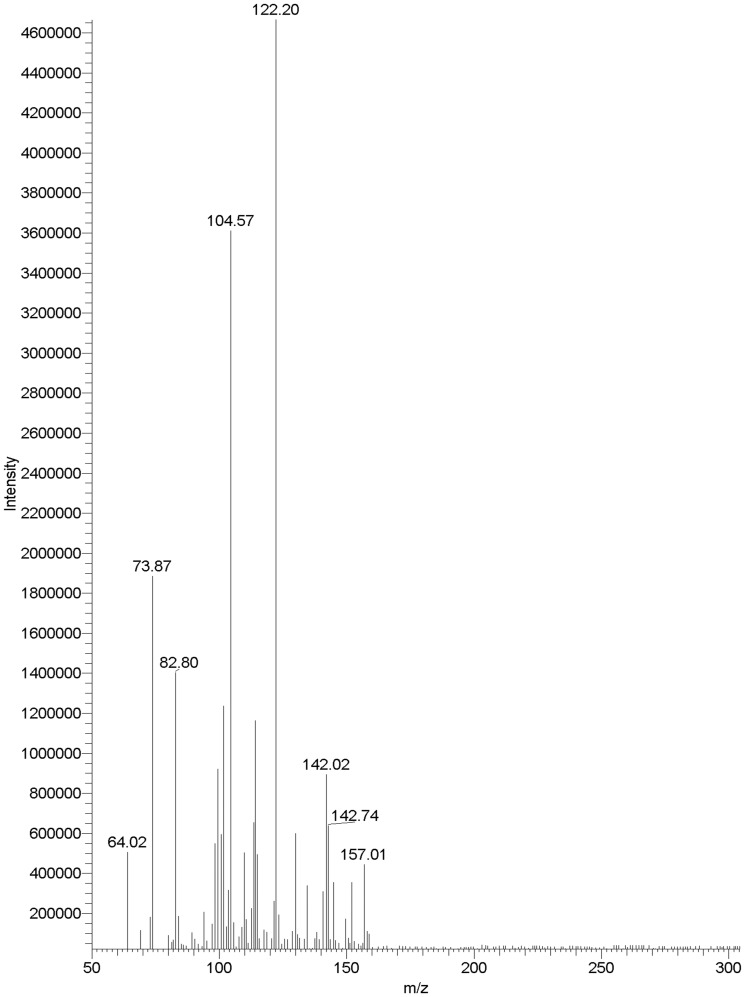
Mass spectrum of the metabolite.